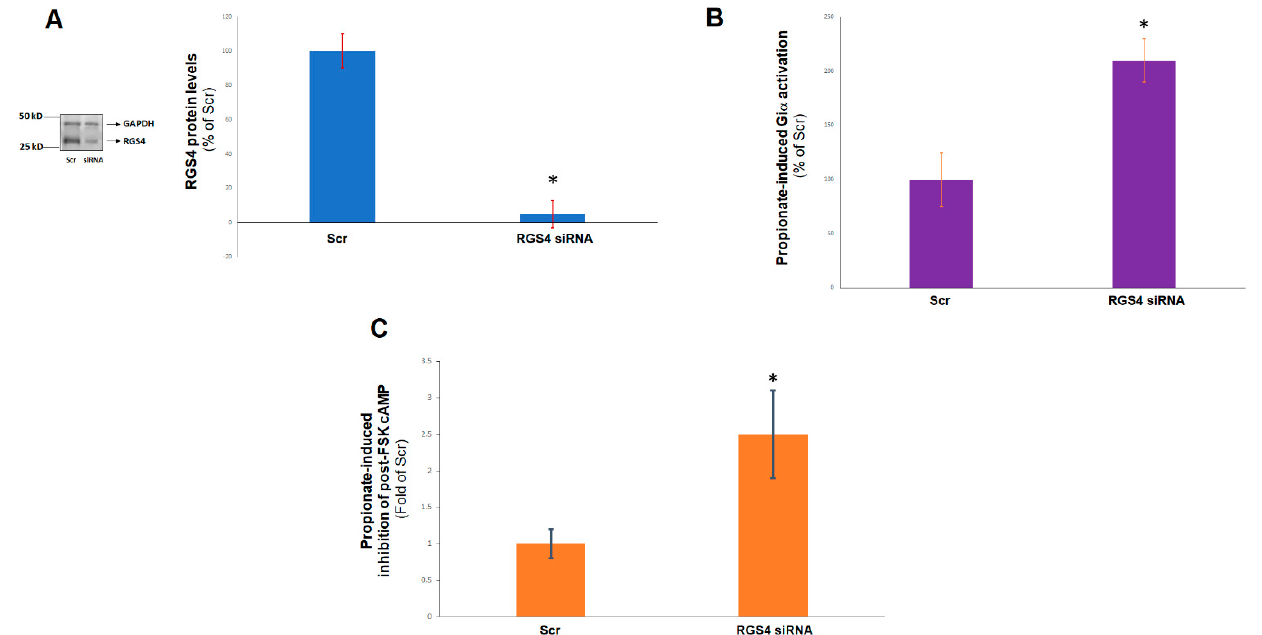
Figure 1. RGS4 and FFAR3-dependent Gi/o protein activation in cardiac myocytes. ( A ) Immunoblot- ting for RGS4 to confirm the efficiency of the siRNA-mediated knockdown of RGS4 in H9c2 cells at 48 hrs post-siRNA transfection. A representative blot, including for glyceraldehyde 3 (cid:48) -phosphate dehydrogenase (GAPDH) as a loading control, is shown on the left, and the % protein reduction, based on densitometric analysis of 4 independent experiments, is shown on the right. Scr: Scrambled siRNA (control); * , p < 0.05; n = 4 independent experiments per condition. ( B ) A 1 mM propionic acid- induced Gi α activation in control (scrambled siRNA-transfected, Scr), or in RGS4-depleted (RGS4 siRNA) H9c2 cells. * , p < 0.05; n = 4 independent experiments. ( C ) A 1 mM propionic acid-mediated inhibition of 10 µ M forskolin (FSK)-induced cAMP accumulation in the same cells, expressed as a % of the inhibition observed in the control (Scr) H9c2 cardiac cells. Forskolin alone induced similar levels of cAMP accumulation in both cell clones (data not shown). * , p < 0.05; n = 4 independent experiments.